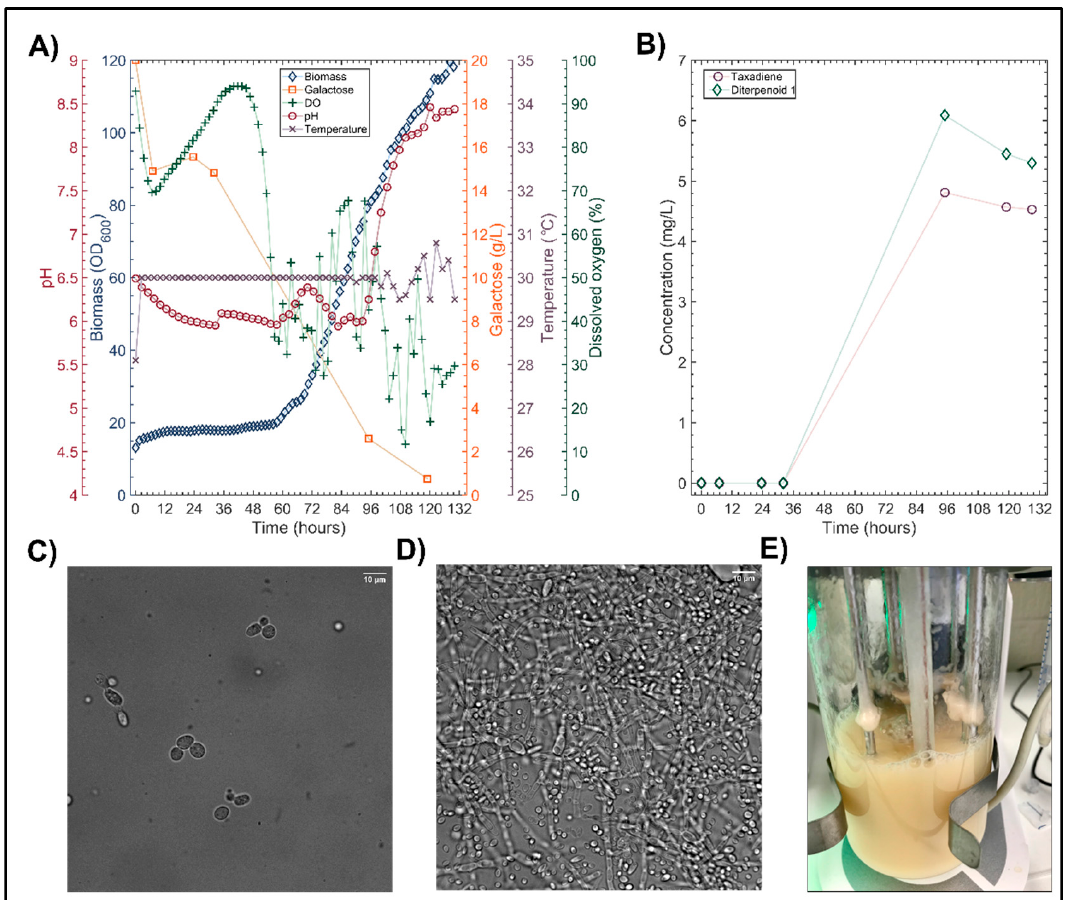
Figure 2. MiniBio 500 bioreactor cultivation. LRS6 was cultivated in the Applikon Minibio 500 bioreactors in YPG prepared with yeast extract lot 175915. ( A ) The temperature ( × ), pH ( o ) and dissolved oxygen (+) were monitored and controlled online to the set points of 30 ◦ C, 6 and 30%, respectively. The biomass ( ⋄) was monitored online using a BE2100 OD scanner (BugLab, Concord, CA, USA). The galactose consumption ( □) was monitored offline via sampling twice daily. ( B ) Total taxane (o) and diterpenoid 1 ( ⋄) accumulation was measured via the GCMS analysis of dodecane extracts of offline samples. Oil immersion brightfield microscope images taken at 32 h ( C ) and at the end of the cultivation ( D ) using a 100 × lens. ( E ) Biofilm formation observed on the bioreactor